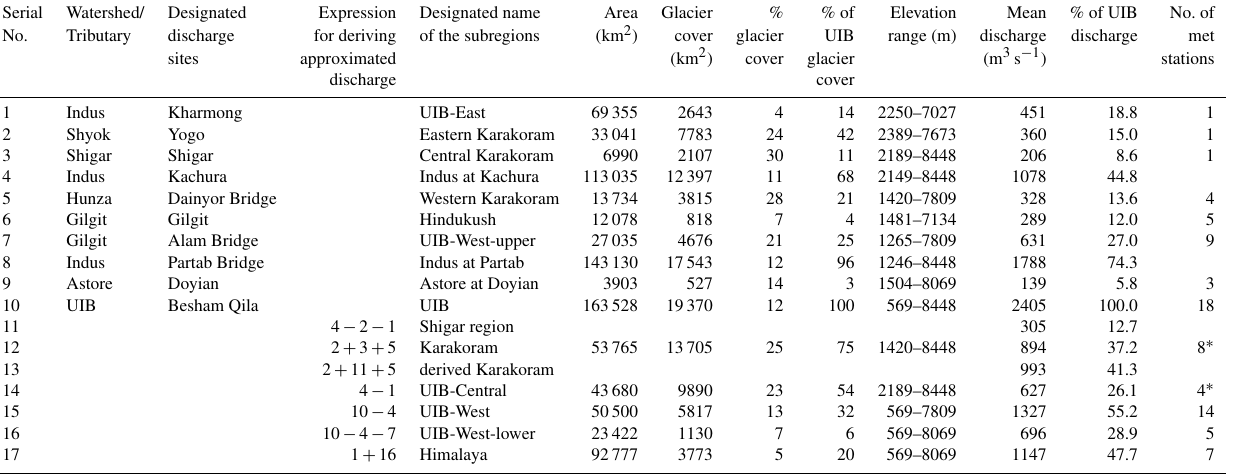
Table 1. Characteristics of the gauged and derived regions of UIB. Note: an asterisk indicates that nearby Skardu and Gilgit stations are included for the Karakoram and Deosai station for the UIB-Central regions. Derived time series are limited to a common length of record for gauges used and thus their statistics.